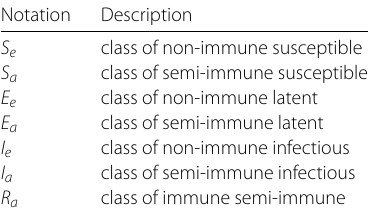
Table 1 Parameters for human hosts